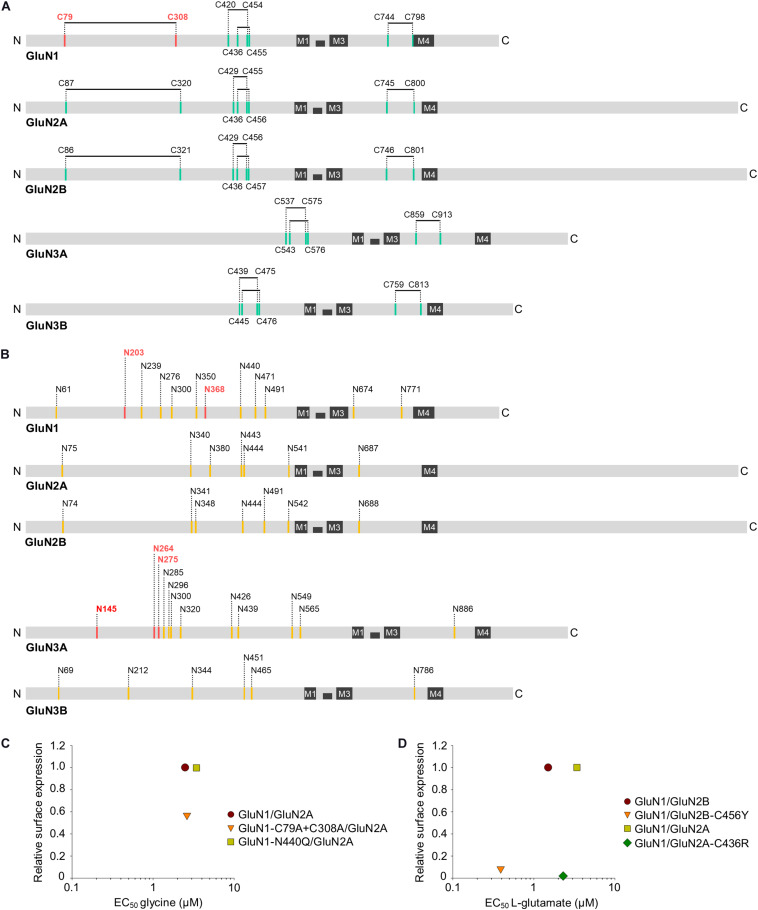
Schematic diagram showing the approximate locations of the predicted disulfide bridges (A) and N-glycosylation consensus sites [N-X-S/T; (B)] in the various GluN subunits. The four membrane domains (M1 through M4) are indicated, and the disulfide bridges and N-glycosylation sites implicated in the ER processing of NMDARs are shown in red (see text for details). (C,D) The relationship of surface expression of mutated GluN1/GluN2 receptors with disrupted disulfide bridges or N-glycosylation site with EC50 values for glycine (C) or L-glutamate (D) (Choi et al., 2001; Papadakis et al., 2004; Lichnerova et al., 2015; Swanger et al., 2016; Sinitskiy et al., 2017). If necessary, the values of the relative surface expression of NMDARs were obtained by calculating values from graphs from the publications using ImageJ 1.52N software (National Institutes of Health, Bethesda, MD, United States) (Schneider et al., 2012).